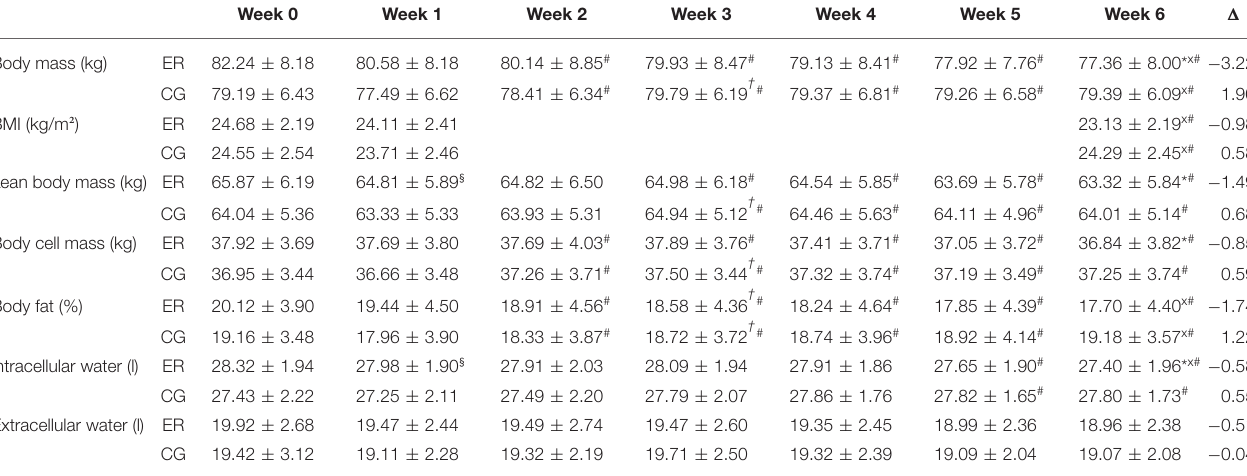
TABLE 2 | Overview of body composition changes in the energy-restricted group (ER) and the control group